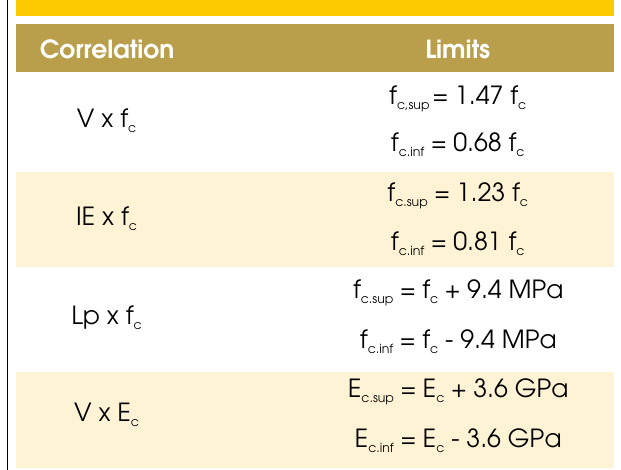
Table 4 – Expressions for the calculation of the superior and inferior limits of isolated